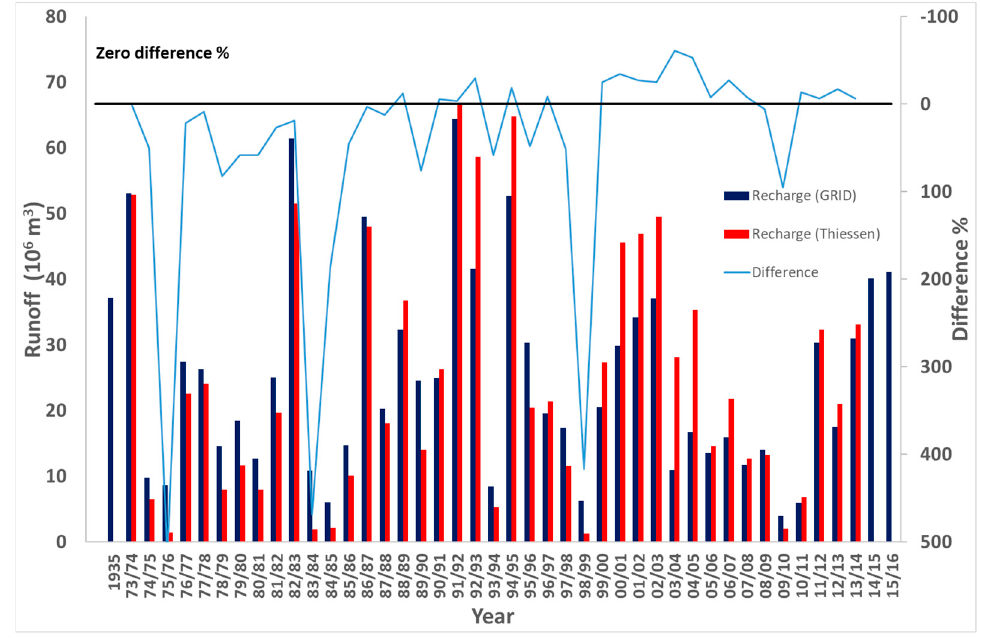
Figure 8. Recharge comparison between Thiessen polygon and GIS GRID methods with yearly difference. Table 6. Comparison between Thiessen polygon method and GIS GRID method on a yearly basis.